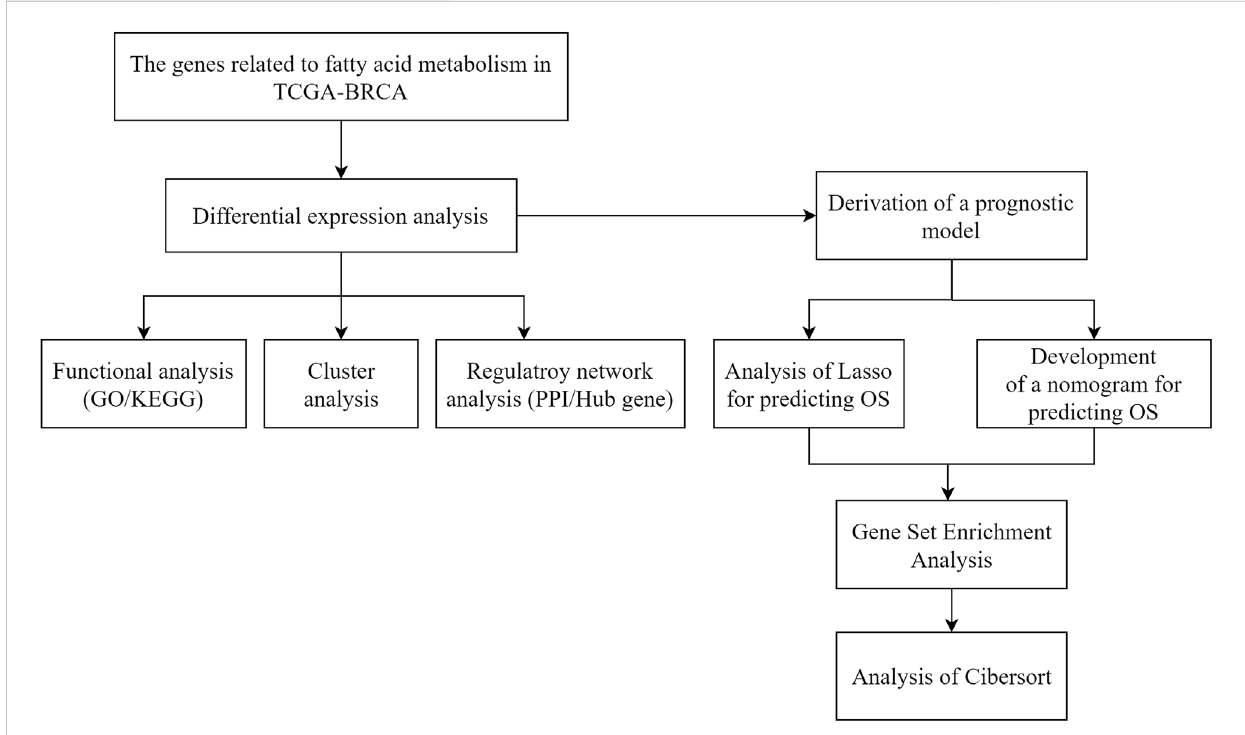
FIGURE 1 Technology roadmap for fatty acid metabolism-related gene prognostic models in breast